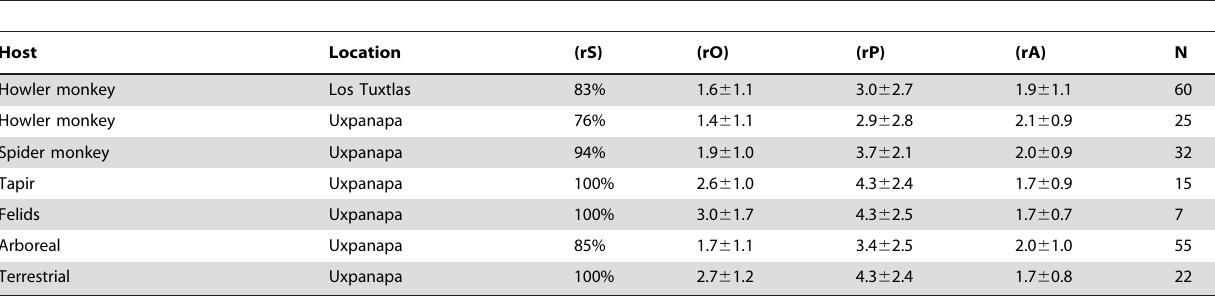
Table 2. Resistance parameters in different host categories, including howler monkeys from two locations and four mammal taxa (two arboreal and two terrestrial) in the same location